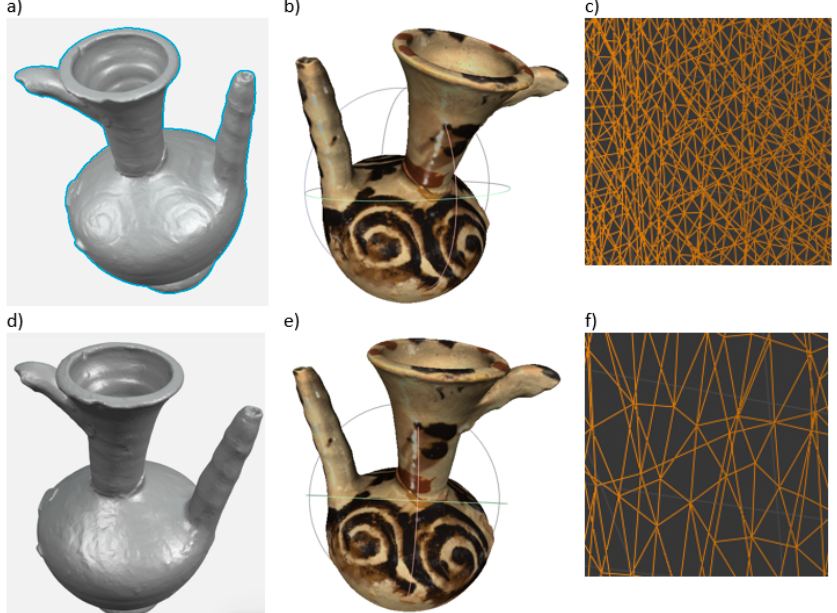
Figure 7. The appearance of a digital 3D model of a jug with 3D SLS: ( a , b ) primary model—without and with texture, ( d , e ) model after additional processing—without and with texture, ( c , f ) mesh view before and after optimization.